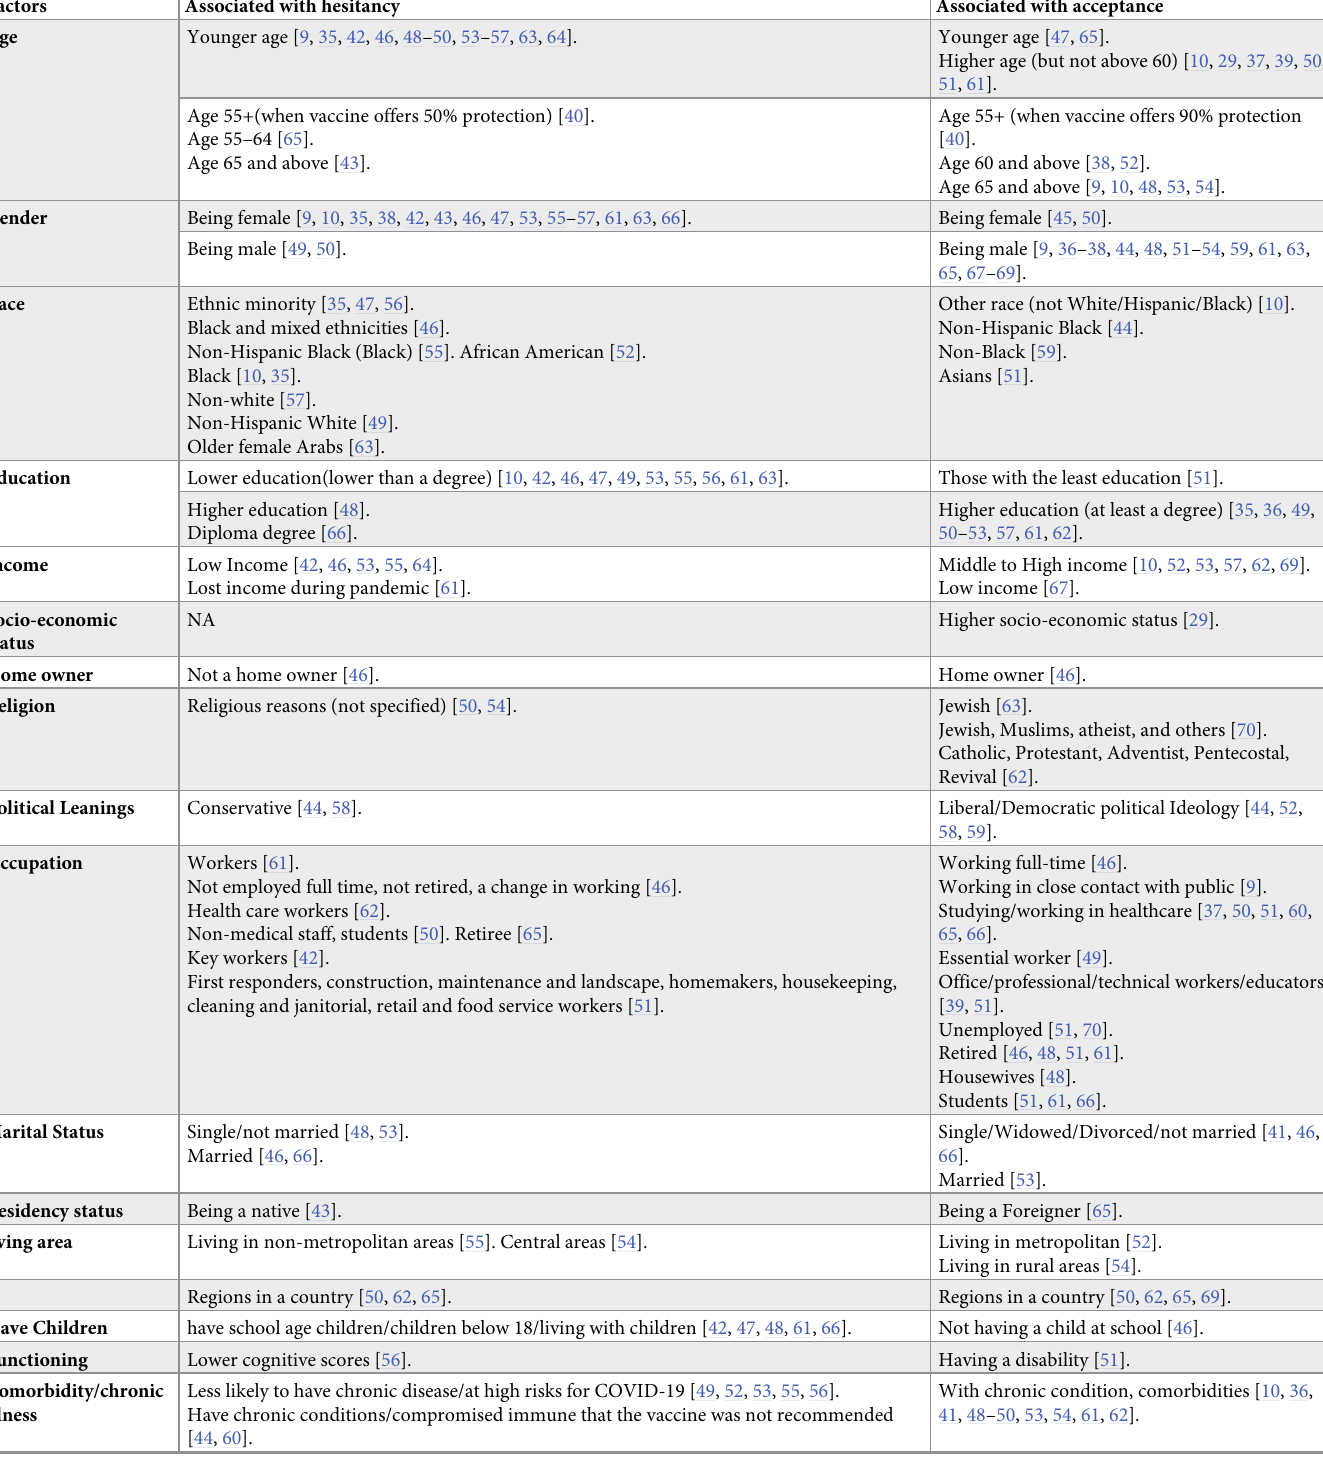
Table 4. Socio-demographic